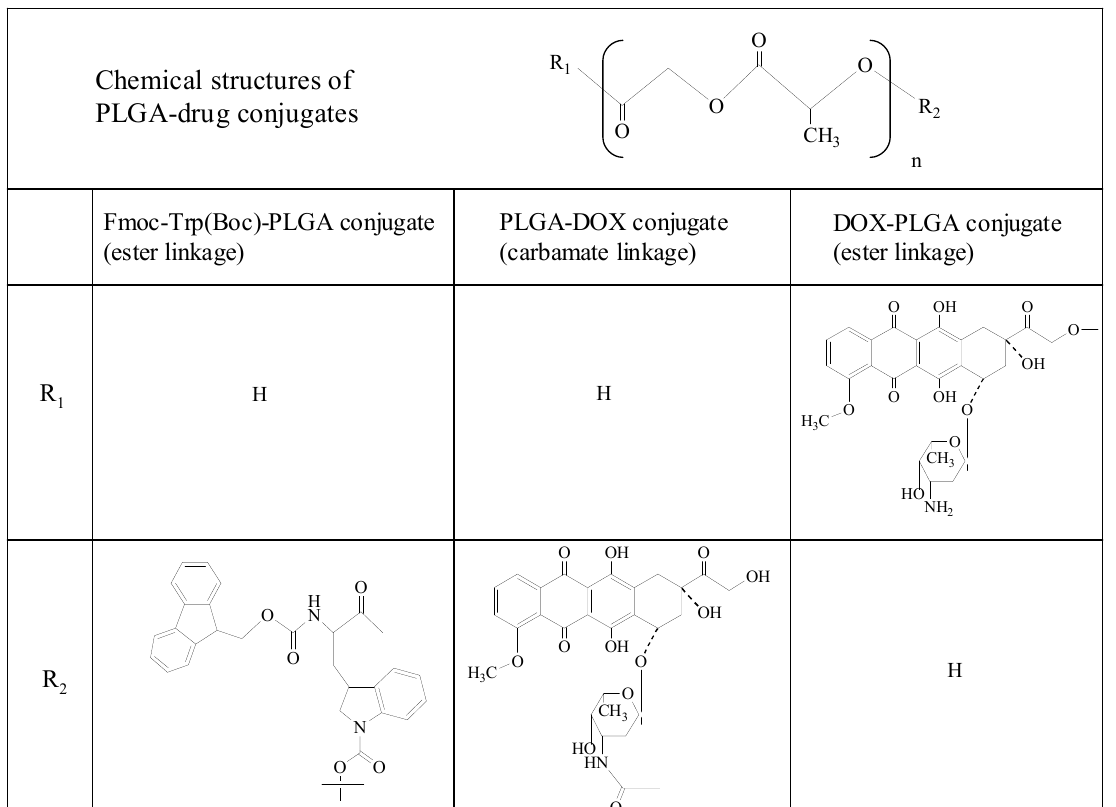
Figure 4. Chemical structure features of PLGA-drug